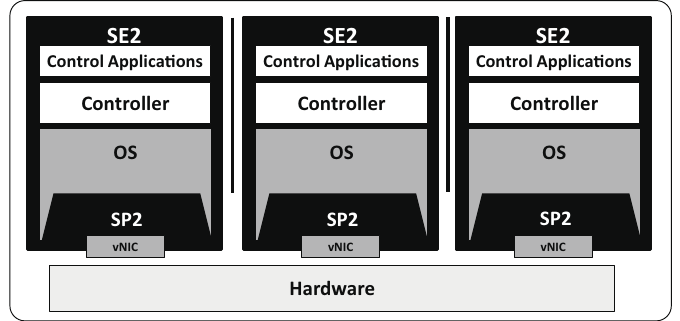
Figure 5. Each control plane consists of an independent SE2 and